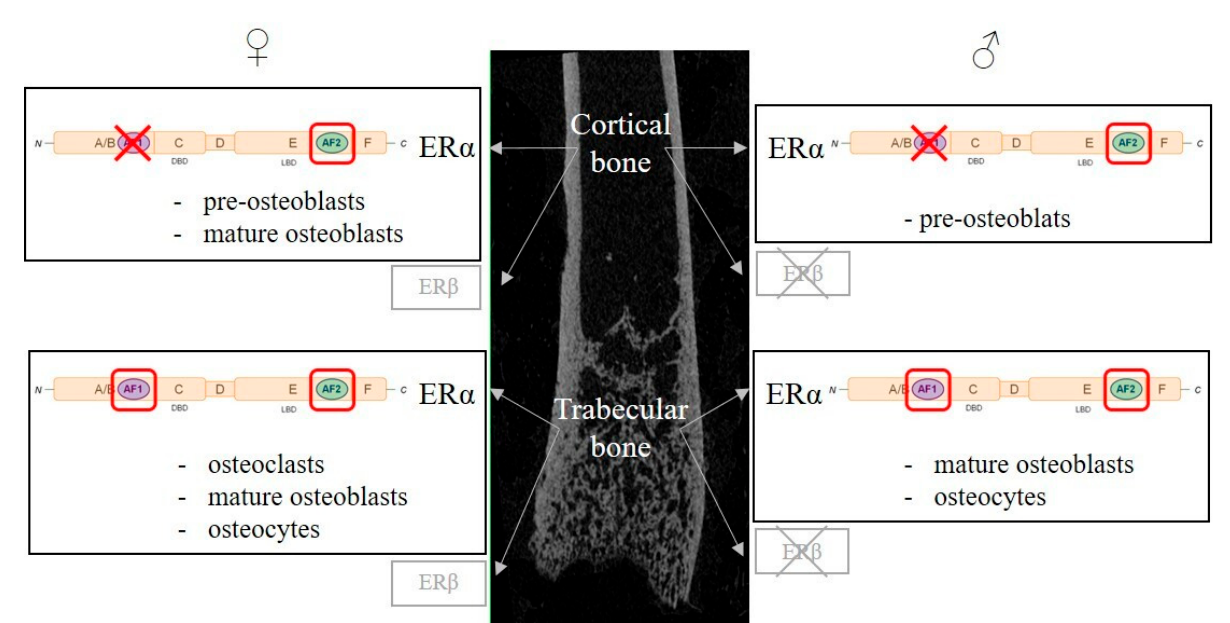
Figure 2. Regulation of bone metabolism by estrogen receptors, cellular and molecular aspects. Estrogen’s protective effects on trabecular and cortical bone are mainly mediated by Estrogen Receptor α (ER α ) in both females and males, while ER β only plays a minor role in female and none in male. ER α belongs to the nuclear receptor superfamily and exerts its transcriptional activity though two activating functions (AFs), AF1 and AF2. Both AF1 and AF2 functions are necessary to mediate estrogen effects, whereas, in the cortical compartment, only AF2 function is necessary in females and males. Genetic murine models have allowed the study of the role of ER α in bone cells (osteoclasts, osteoblasts and osteocytes). For each bone compartment and sex, the cell types involved in estrogen’s protective effects are indicated. A red box highlights essential ER α subfunctions in each cell type, whereas a red X indicates the dispensable ER α subfunction.